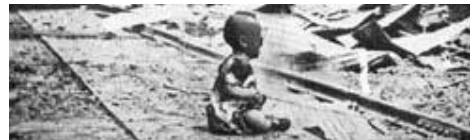
Figure 3. Baby Ping-Mei. Source: LOOK Magazine.